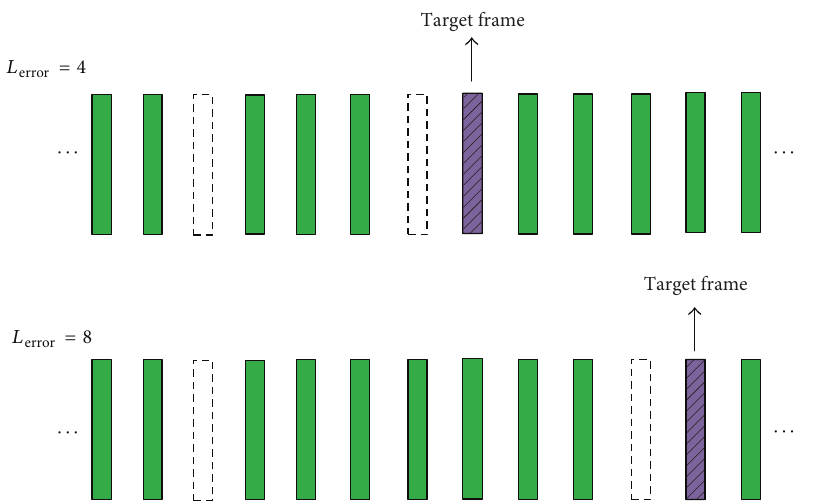
Figure 9: Multiple packet loss occurs with different error propagation length.